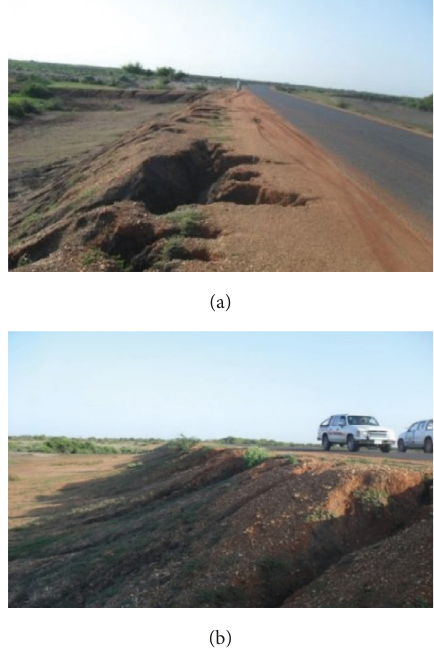
Figure 2: The eroded slope of Wad Medani-Sennar